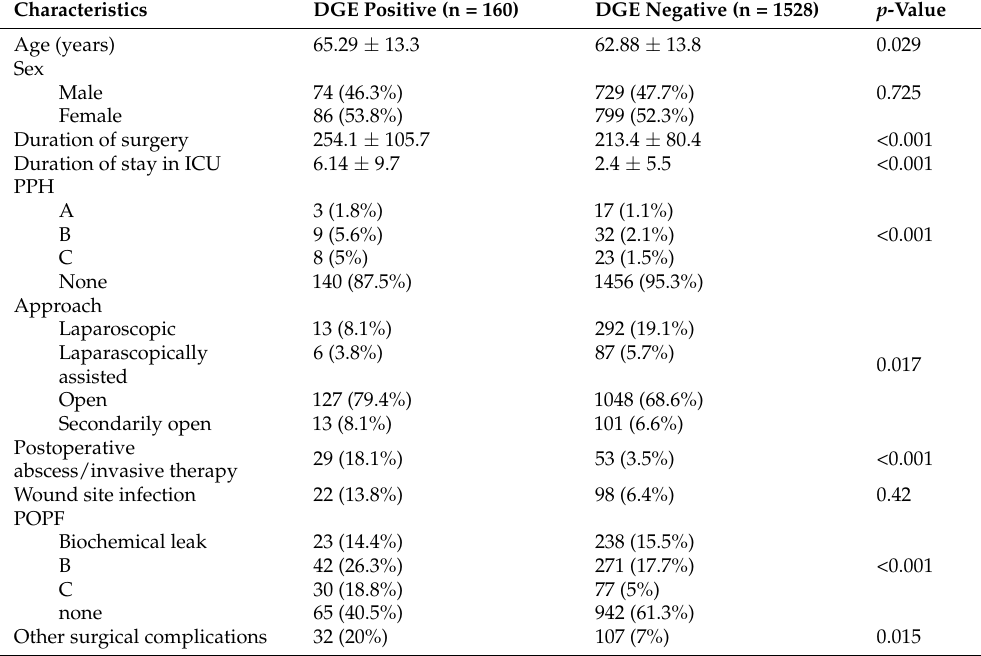
Table 4. Univariate evaluation of the DGE and non-DGE group; significant p -values are printed in bold letters; abbreviations: ICU, intensive care unit; PPH, postpancreatectomy hemorrhage; POPF, postoperative pancreatic fistula; DGE, delayed gastric emptying.